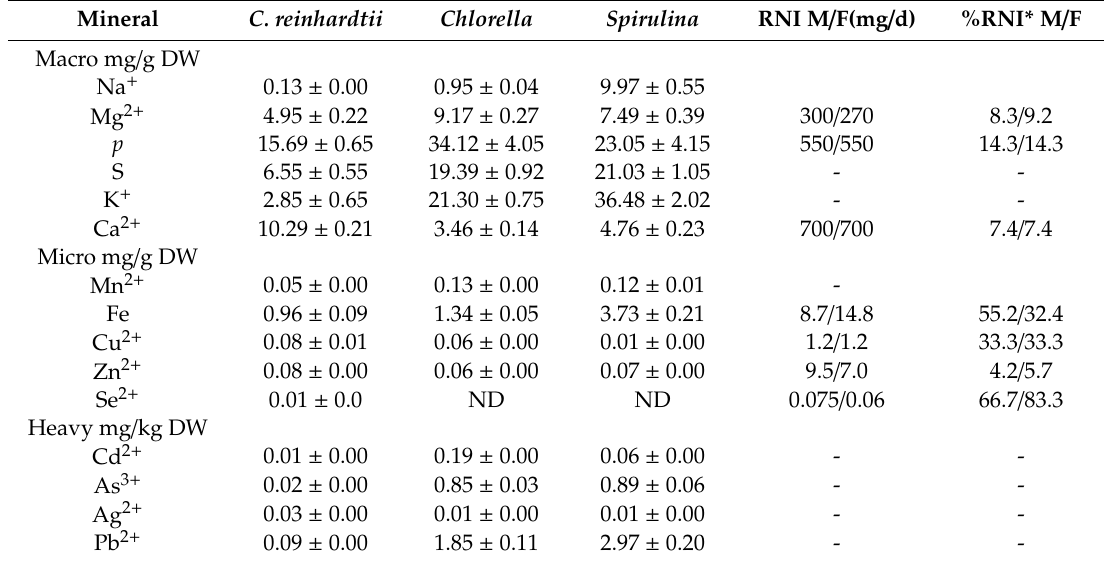
Table 3. Mineral composition of C. reinhardtii , Spirulina and Chlorella